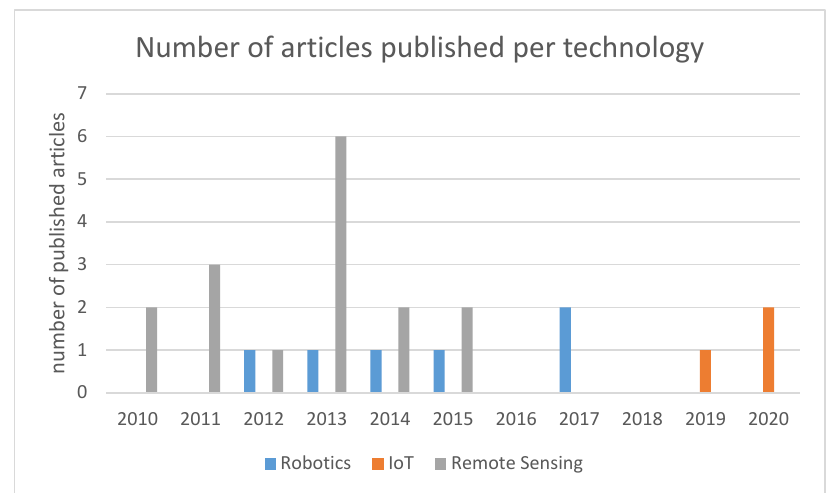
Figure 2. Numbers of publications on robotics, IoT, and remote sensing during 2010 – 2020 (results referring to Cyprus Climate-smart agriculture applications).